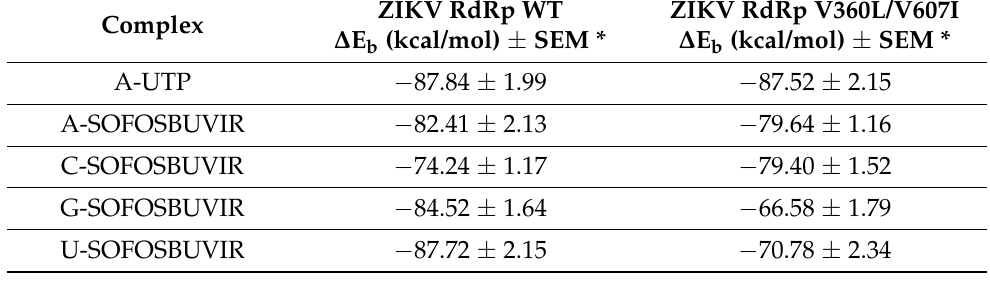
Table 3. Molecular Mechanics Generalized Born Surface Area (MM-GBSA) theoretical affinity of